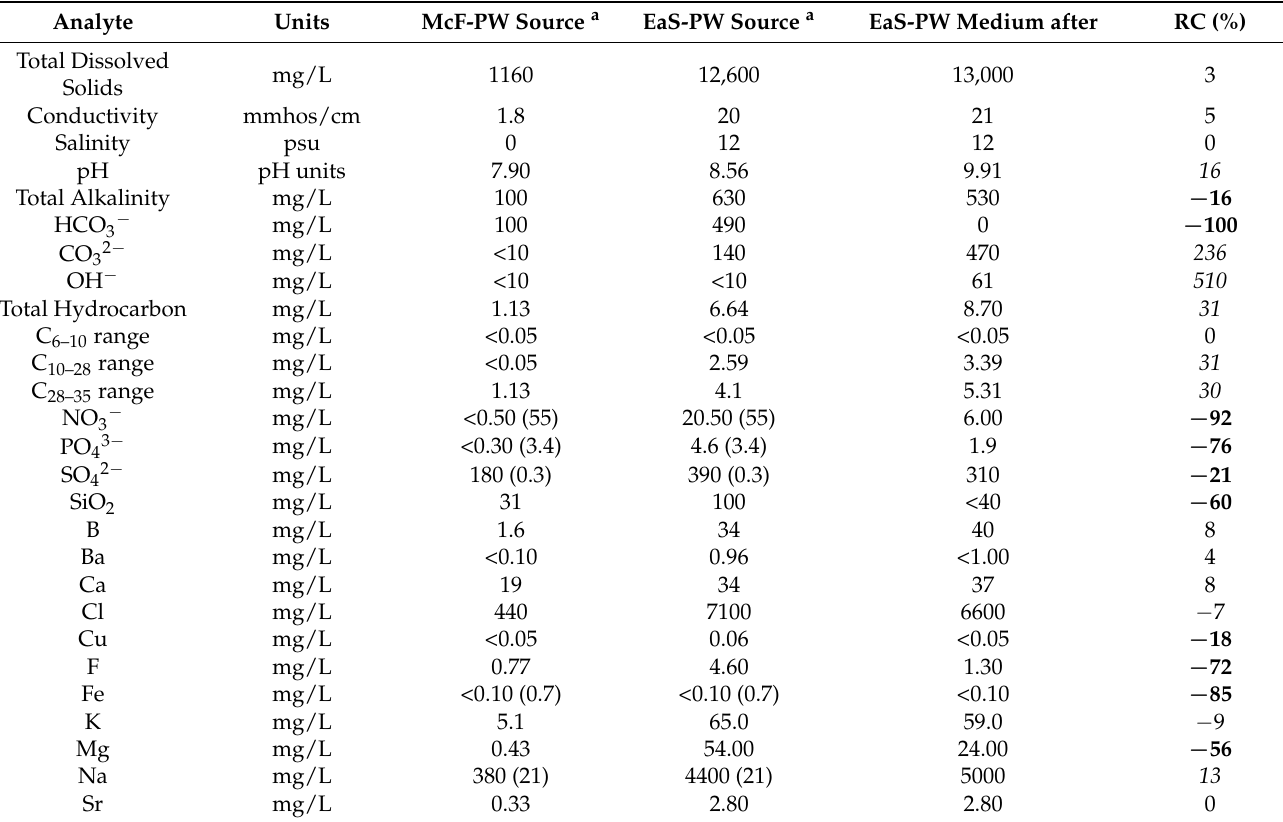
a Values between parenthesis correspond to the quantity of the analyte that was supplemented after chemical analysis as part of the medium enrichment (see Supplemental Table S1 for calculations). For these analytes, the relative change (RC) is calculated using the total estimated concentration in the medium (i.e., sum of the measured concentration and supplemented